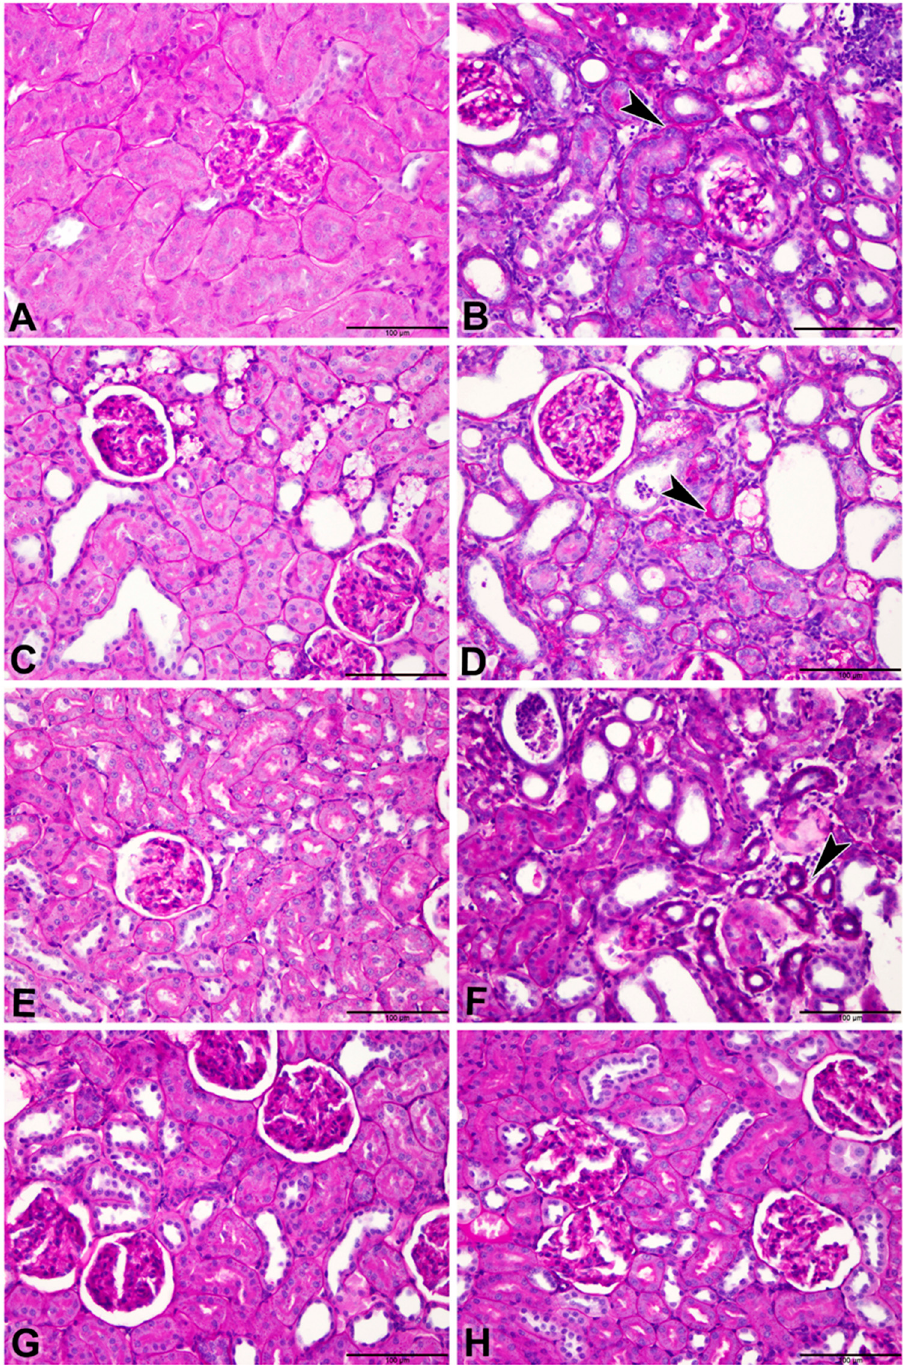
Figure 5. Representative photographs of Periodic Acid–Schiff (PAS) staining on sections of renal tissues (Bar = 100 μ m) from control rats and rats treated with adenine ( A ), streptozotocin (STZ), and metformin (MF), alone or in combination. Control rats and rats treated with MF only (( A , E ), respectively) showed normal renal histology. ( B ) Adenine ( A , D ) A + STZ alone treated groups shows tubular atrophy represented by a thickened tubular basement membrane (arrow) stained positive (magenta red). ( C ) STZ (STZ) group shows only a slight change in tubular atrophy, when compared to control group. ( F ) Adenine-MF (A + MF) group showing a thickened tubular basement membrane (arrow). ( G ) STZ + MF and ( H ) A + STZ + MF groups showed improvement in the histologic appearance and a significant decrease in tubular atrophy.